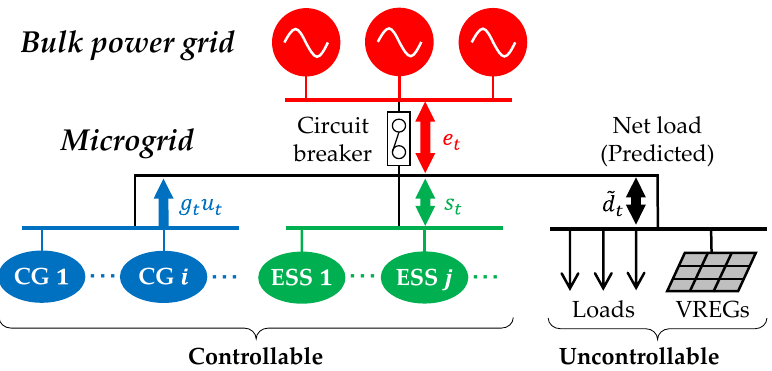
Figure 1. Conceptual illustration of microgrids. For detailed definitions of the variables in the figure, refer to Section 2.1.